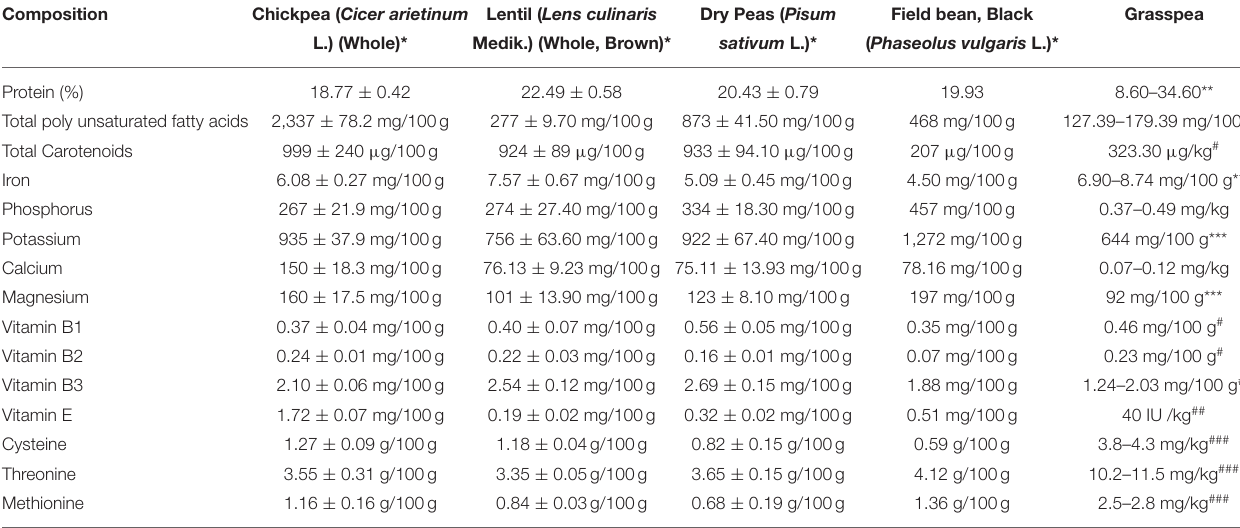
TABLE 3 | Comparative table on nutritional values of grasspea ( L. sativus L.) with other cool season legumes. Composition